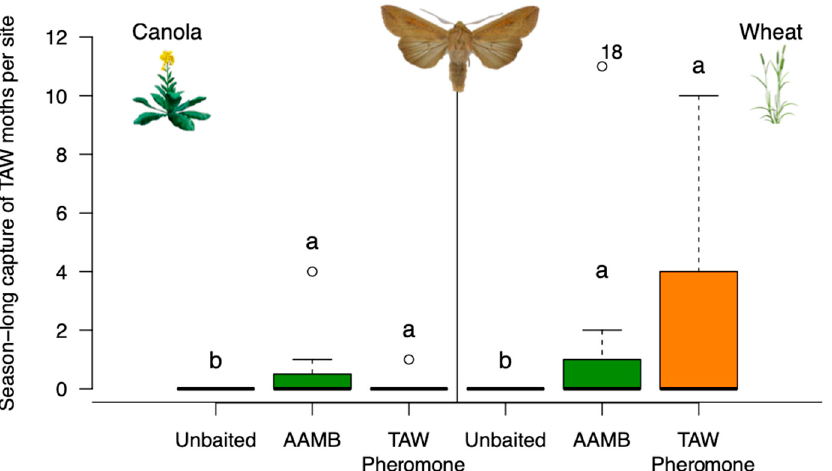
Figure 2. Experiment 1—box-and-whisker plot of the season-long capture of true armyworm (TAW) moths in baited traps at seven sites in central Alberta, Canada. Open circles represent points more than 1.5 times the interquartile range. Traps were baited with either a TAW sex pheromone, AAMB lure or left unbaited as control trap. Means comparisons were performed for differences in trap capture. Boxplots marked with different letters are statistically different (Tukey method, α = 0.05). (Open circle beside number 18 is data point out of y-axis range)